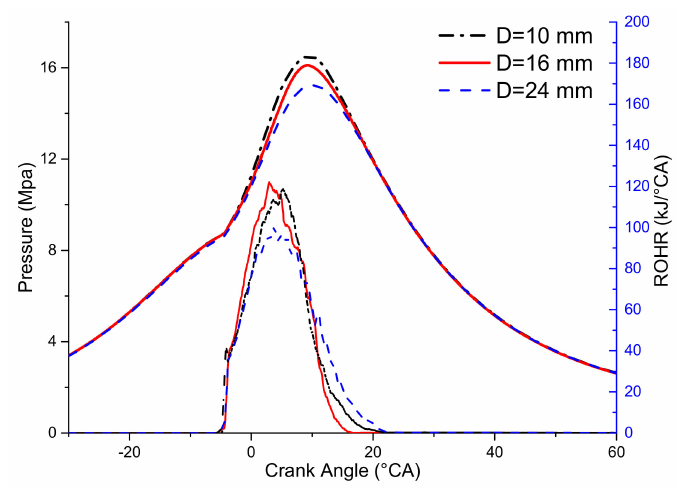
Figure 11. Pressure and heat release rate at di ff erent PCC nozzle diameters.